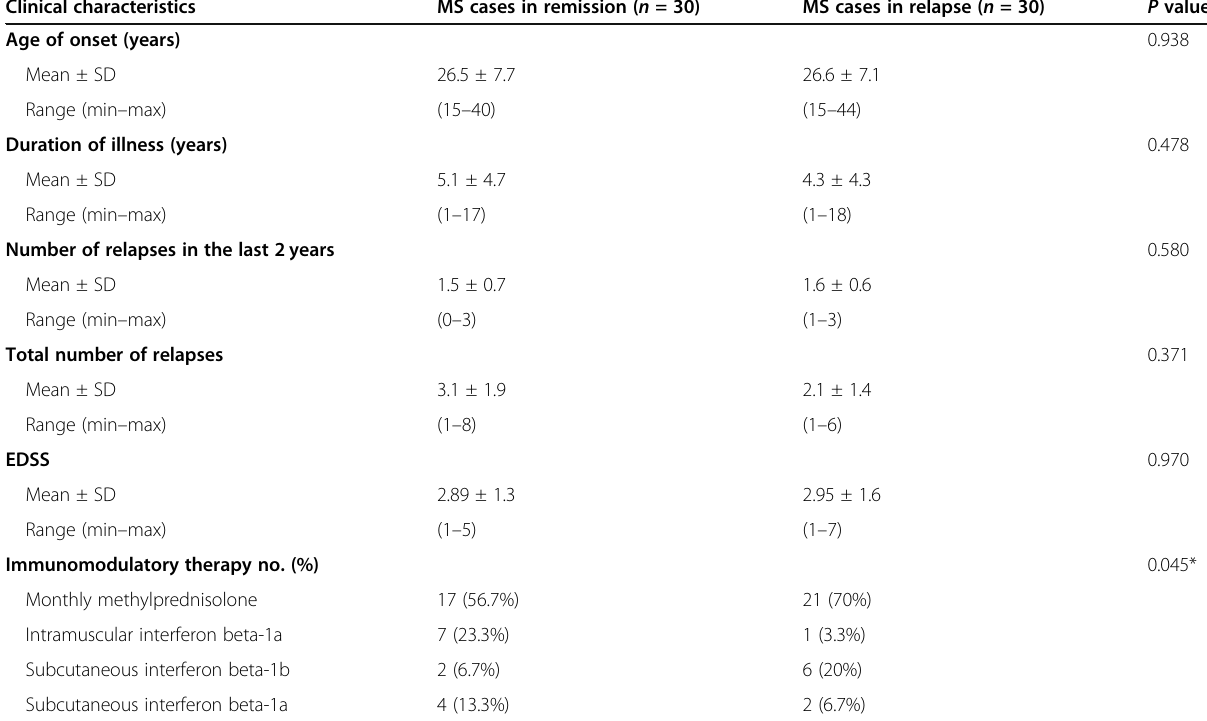
Table 2 The baseline clinical characteristics of MS patients Clinical characteristics